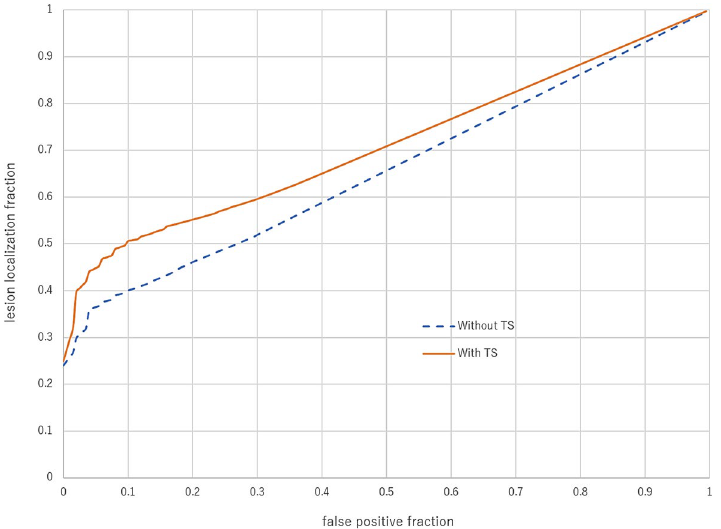
Figure 3. Average free-response receiver operating characteristic curves without (dotted blue line) and with (red solid line) temporal subtraction (TS) images. Radiologist performance significantly increased with the assessment with TS compared with assessment without TS.